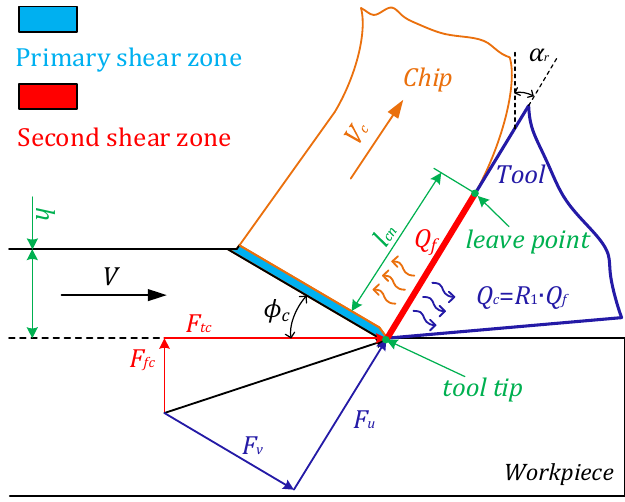
Figure 1. Cutting power consumption in metal cutting.